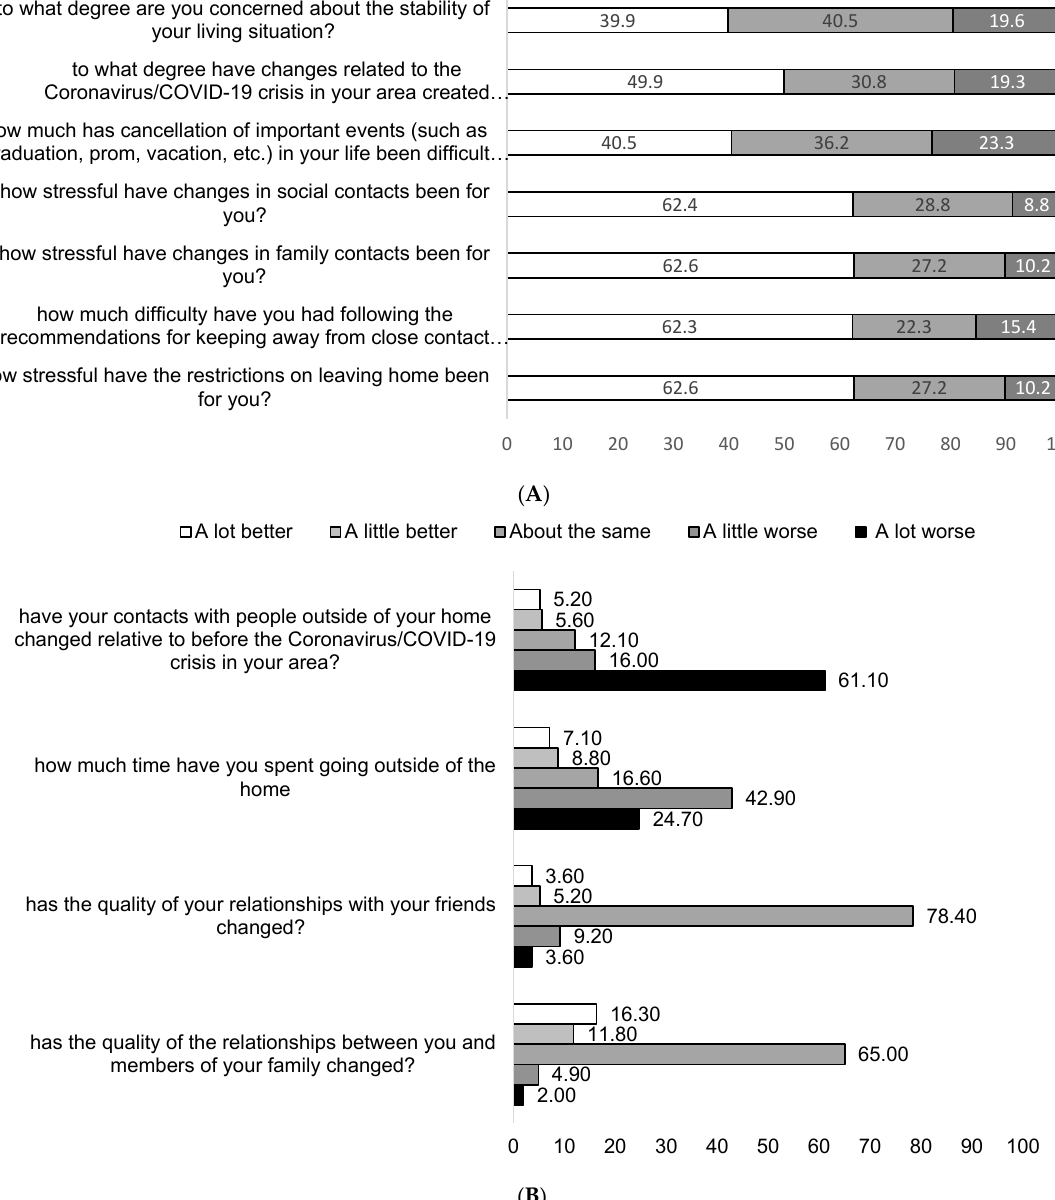
Figure 1. ( A,B ) Life changes during the COVID ‐ 19 pandemic ( N = 308). Figure 1. ( A , B ) Life changes during the COVID-19 pandemic ( N =